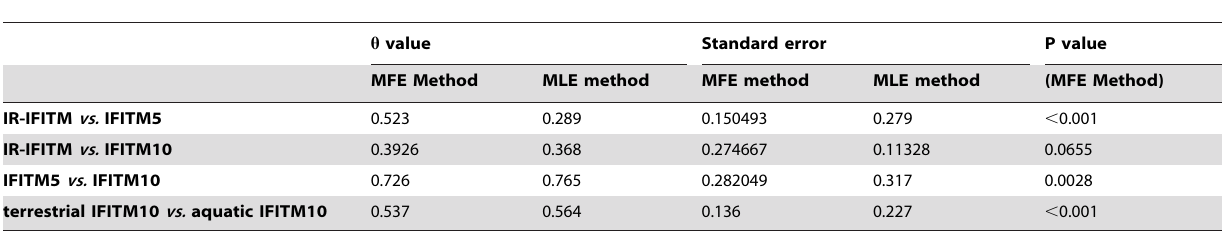
Table 2. Functional divergence of the vertebrate IFITM